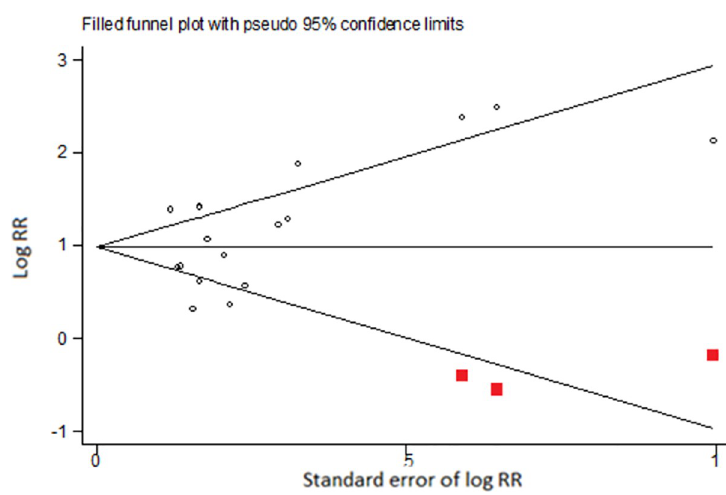
Fig 8. Funnel plot illustrating results from trim-and-fill analysis of adjusted log RRs for outcome ever e-cigarette use at baseline and ever cigarette use at follow-up.